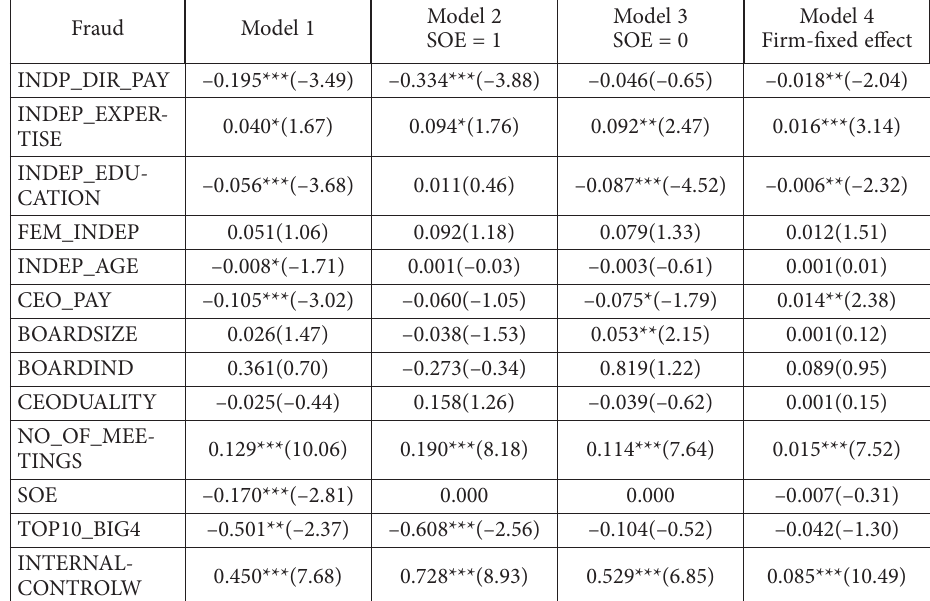
Table 4. Regression results of H1 &